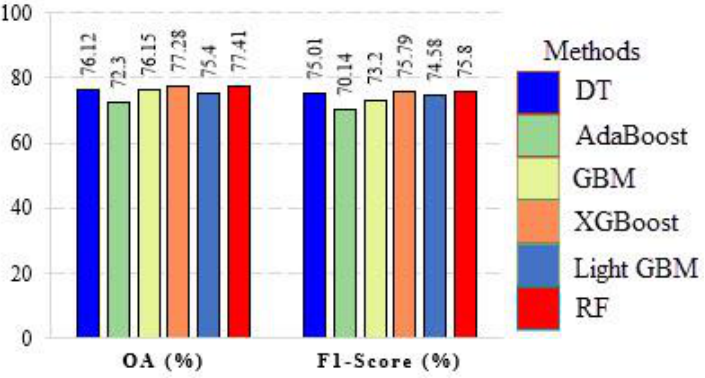
Figure 15. Numerical evaluation of EL techniques in the classification of the multispectral dataset.